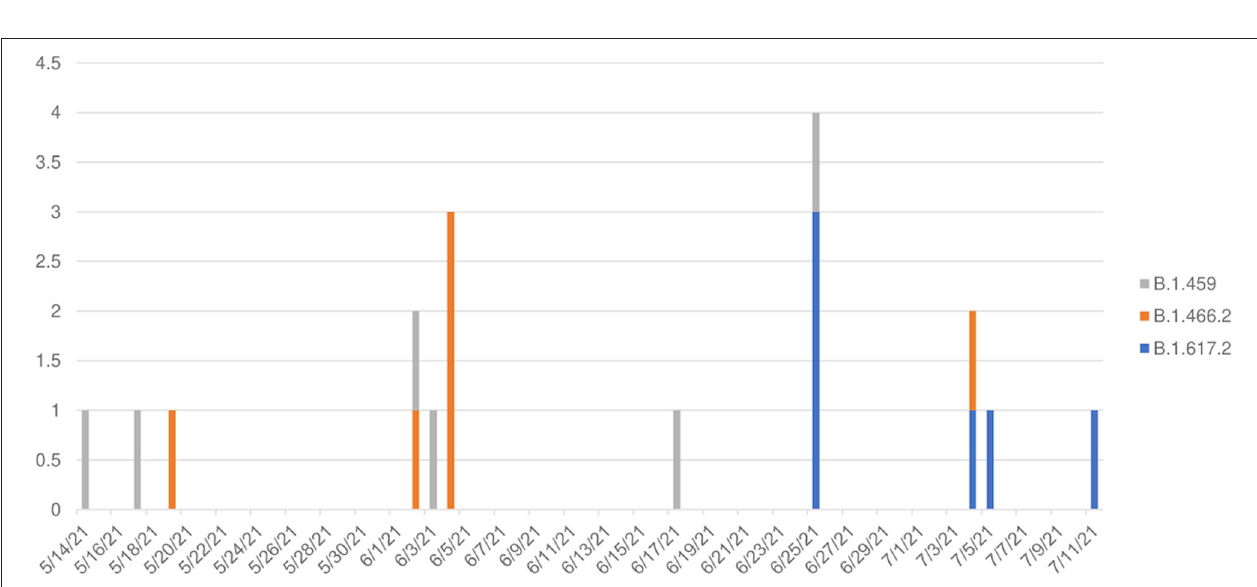
FIGURE 2 | Phylogenetic tree built with Nextclade v1.5.4. (A) Highlighted 18 viruses as reported in Table 2. (B) Focused view of where the 6 Delta variants are located under the 21A clade (Delta variants). (C) Focused view of the other 12 viruses under clade 20A.